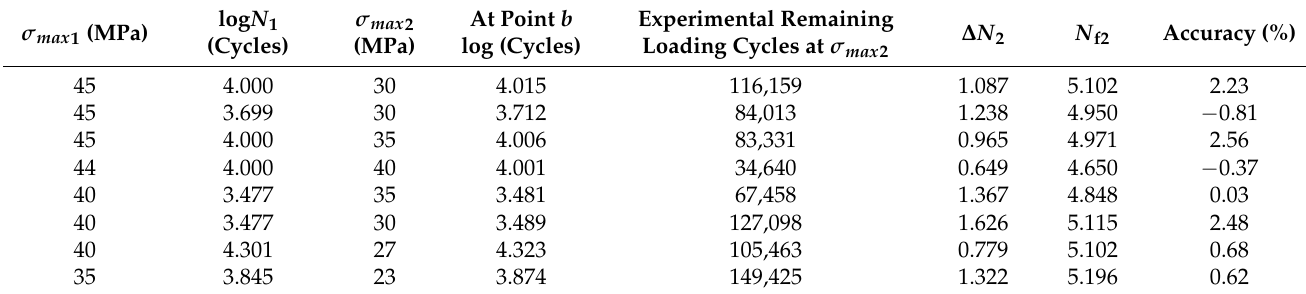
Table 2. Low–high fatigue loading for the remaining fatigue life.